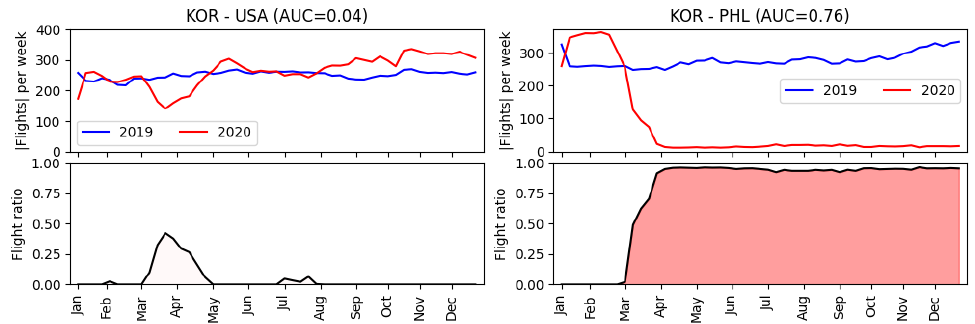
Figure 2. Comparison of flight ratio discrepancy for two selected countries pairs: Korea–United States ( left ) and Korea–Philippines ( right ).